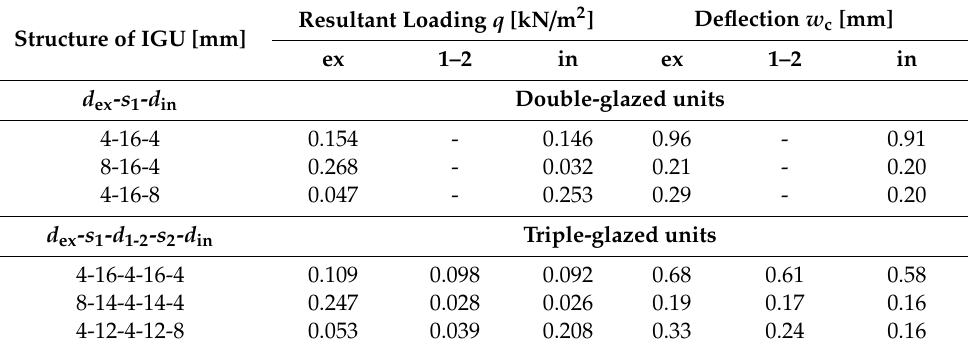
Table 7. Static quantities in IGUs loaded with wind pressure of 0.3 kN / m 2.